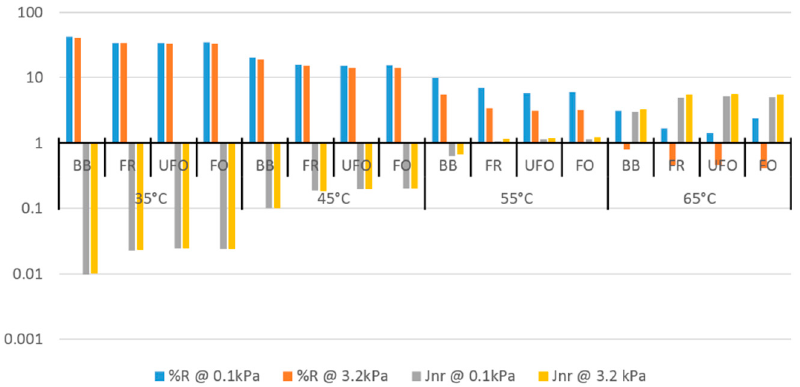
Figure 12. %Recovery and J nr at different temperatures.